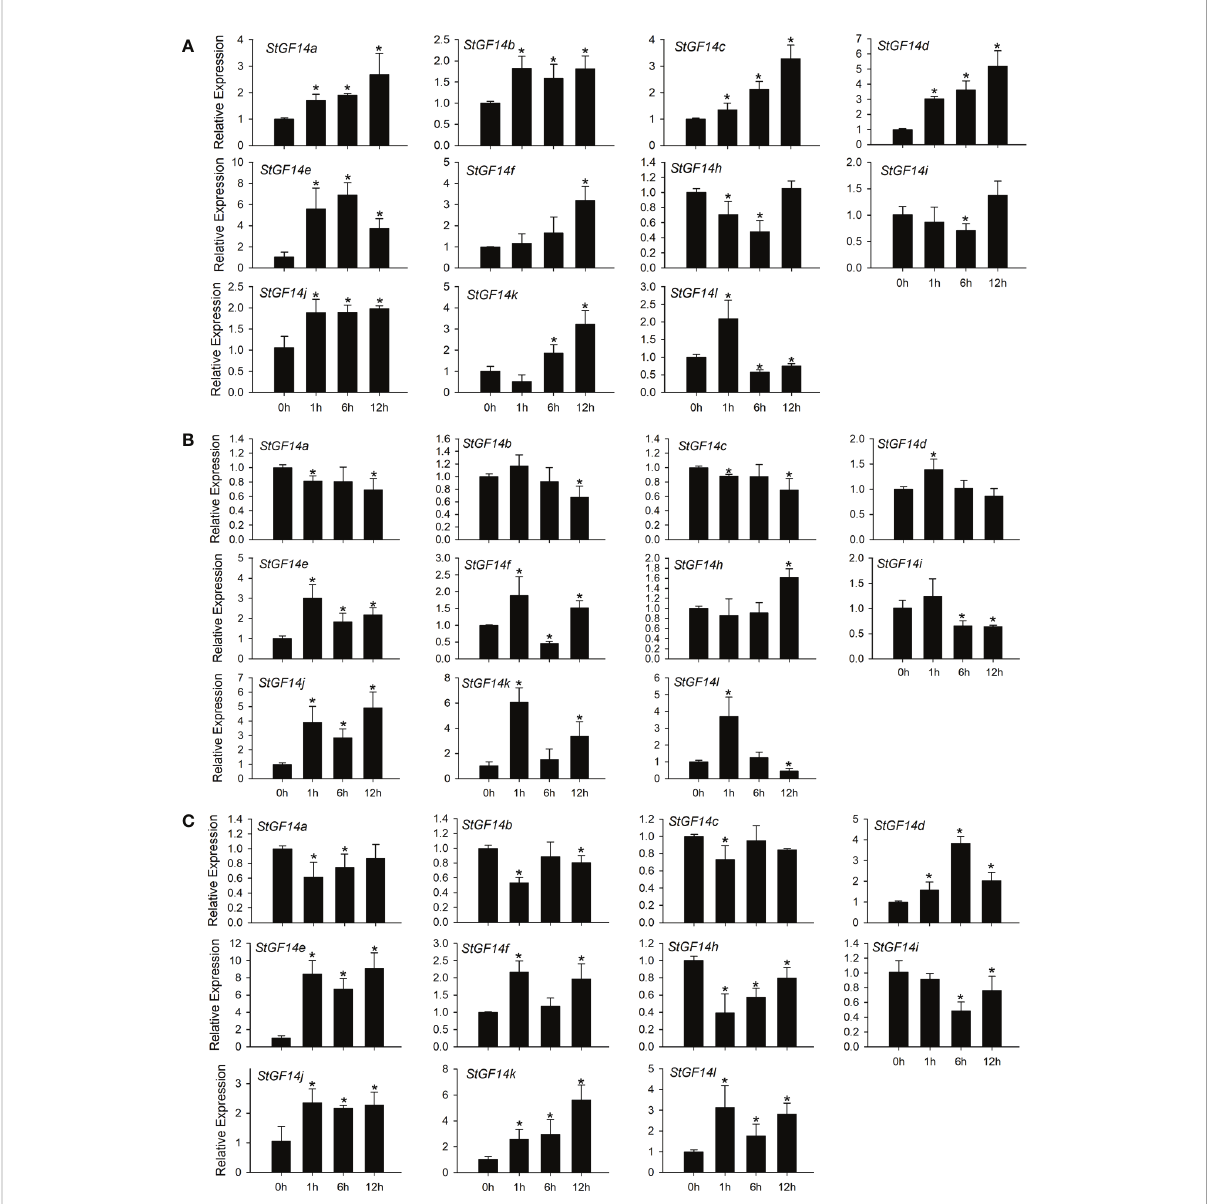
FIGURE 6 Expression analysis of potato14-3-3s in response to drought, salt and ABA treatments. The potato seedlings were treated with 100 µM ABA (A) , 100 mM NaCl (B) , and 15% PEG 6000 (C) . The signi fi cant differences between data were calculated using Student ’ s t test, and indicated with an asterisks (*), P < 0.05.